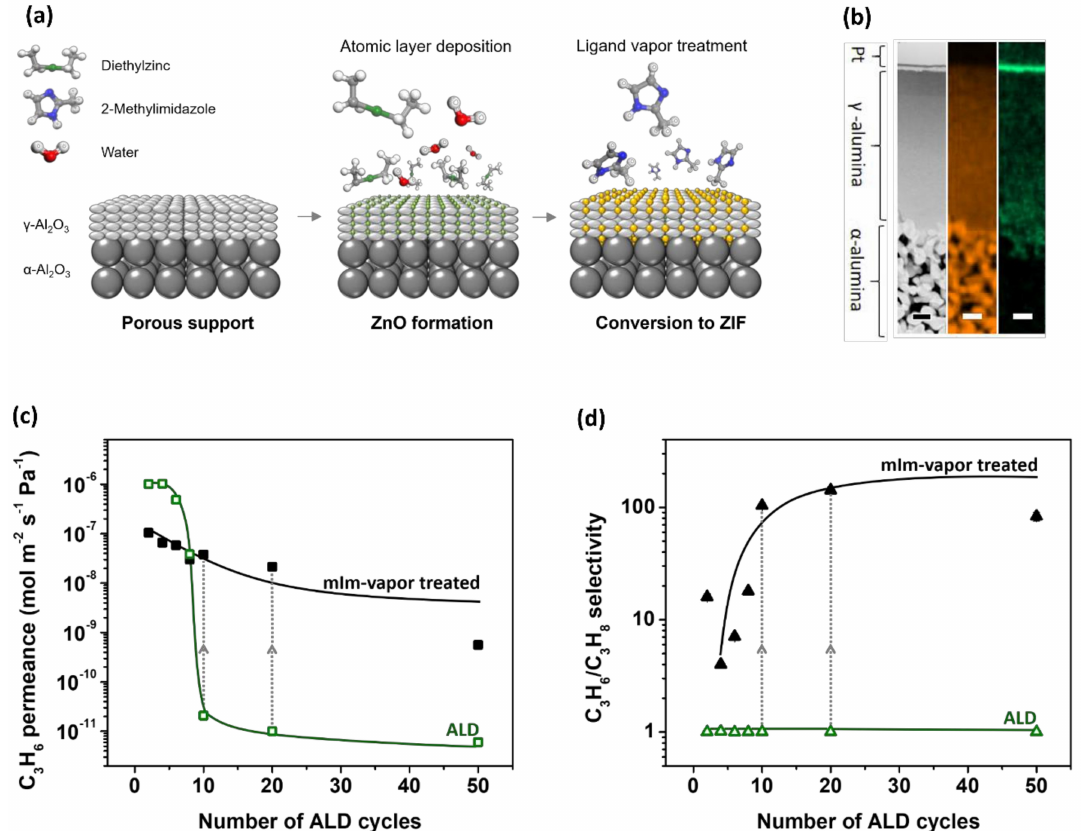
Figure 8. ( a ) Schematic of the all-vapor phase LIPS membrane fabrication process. ( b ) Cross section ADF-STEM image and corresponding spatial distribution of aluminum (orange) and zinc (green) for the ZIF-8 nanocomposite membrane. ( c ) Propylene permeance and ( d ) propylene/propane single component selectivities of the ALD treated support (green open symbols) and the corresponding ZIF-8 membranes (black solid symbols) as a function of the number of ALD cycles